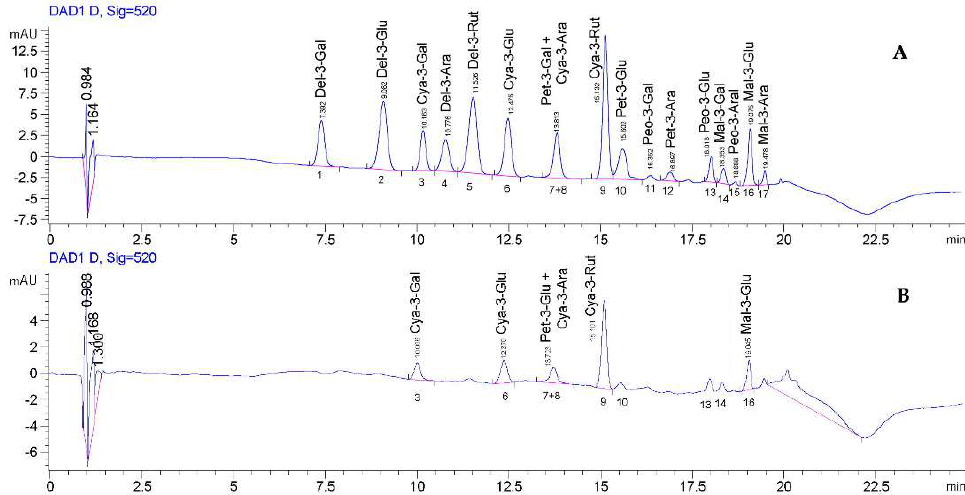
Figure 3. HPLC–DAD representative chromatograms (see the text for details). Anthocyanin profile of sham-digested extract ( A ) and intestinal digested phase ( B ). The chromatograms were acquired